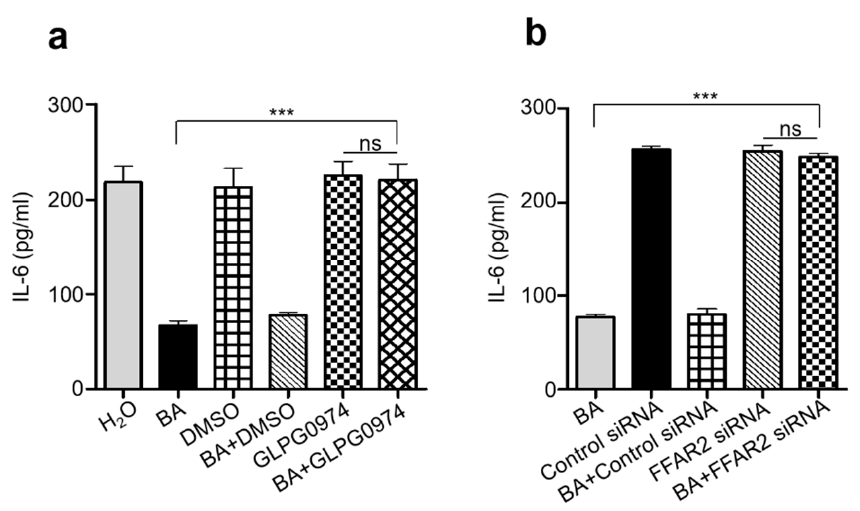
Figure 4. Blocking FFAR2 prevents the butyric acid mediated amelioration of inflammation. ( a ) The level of IL-6 in the dorsal skin of ICR mice upon gavage feeding of FFAR2 antagonist GLPG0974 dissolved in dimethyl sulfoxide (DMSO) in saline (0.01%) and topically applied butyric acid (BA) (4 mM) and was measured by ELISA. Mice fed with DMSO in saline and topically applied with H 2 O were included as control. ( b ) The level of IL-6 in the dorsal skin of ICR mice subcutaneously injected with FFAR2 siRNA 10 min prior to topical application with butyric acid (BA) (4 mM) was measured by ELISA. Mice injected with scrambled or negative control siRNA and topically applied with H 2 O were included as control. Data are the means of three separate experiments using five mice per group. ns = non-significant. *** p < 0.001. (two-tailed t